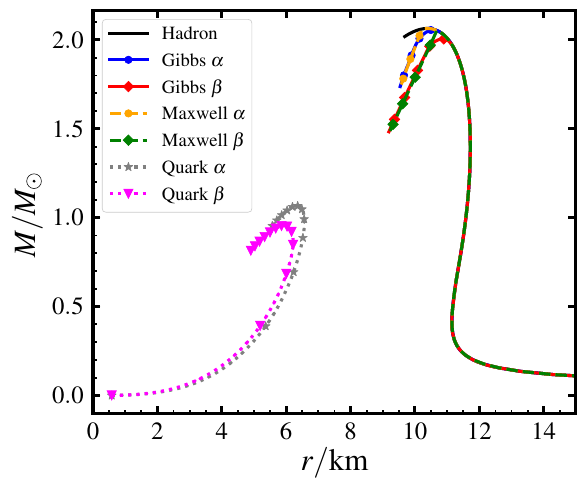
0 Fig. 9 Calculated mass-radius relation of the compact star in the cases we take consideration. The black solid line corresponds to the pure hadron star, the solid lines with symbols stand for the results via the Gibbs construction, the dashed lines with symbols represent the results with the Maxwell construction, and the dotted lines with symbols cor- respond to the results of the pure quark matter. The α , β in the legend denotes the DS equation result by implementing the α -, β -type modifi- cation,